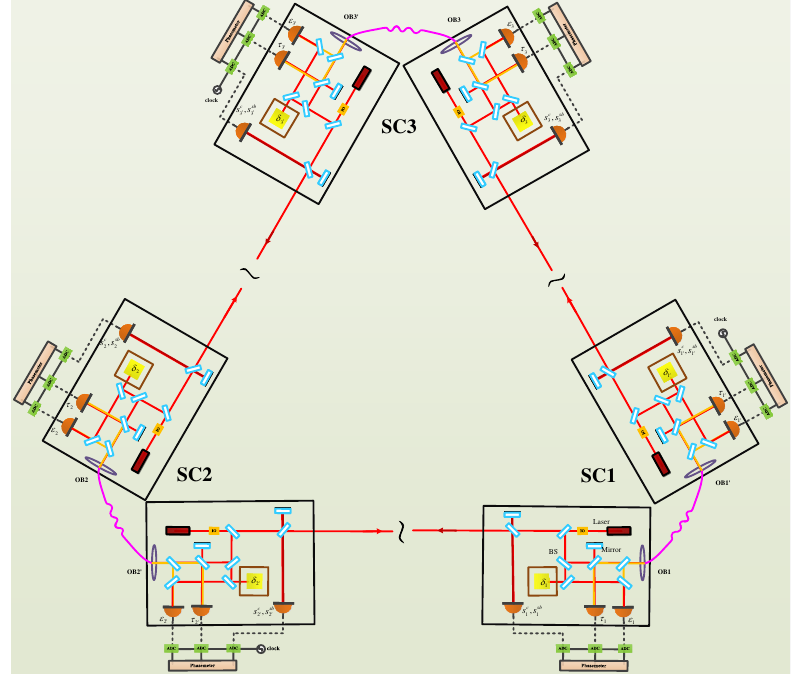
Figure 1. Optical and electrical setup of the inter-spacecraft.